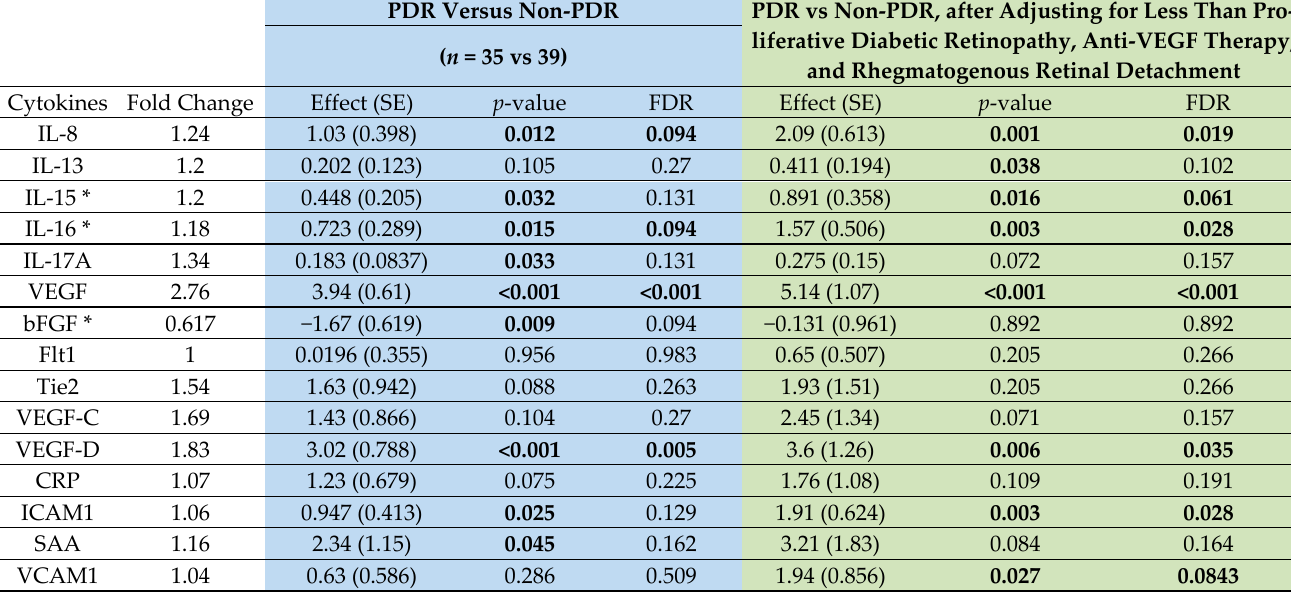
Primary and secondary analyses of cytokine profiles in PDR against control groups. Cytokines listed have significant associations with PDR in our study and in previous studies. Blue-highlighted columns list cytokine values for PDR versus non-PDR patients while adjusting for age and sex as covariates. Green-highlighted columns indicate association after adjusting for age, sex, non-proliferative retinopathy, prior anti-VEGF therapy and rhegmatogenous retinal detachment. Positive value indicates positive association, and negative value indicates negative association. Fold change is the mean level of the cytokine in cases compared to controls. FDR, or false discovery rate, is shown for both analyses, with an a priori cut-off value of 0.10, or 10%. Bolded values indicate statistical significance or those that fall under the FDR cut off. * Indicates novel cytokine associations not previously reported. SE = Standard Error.